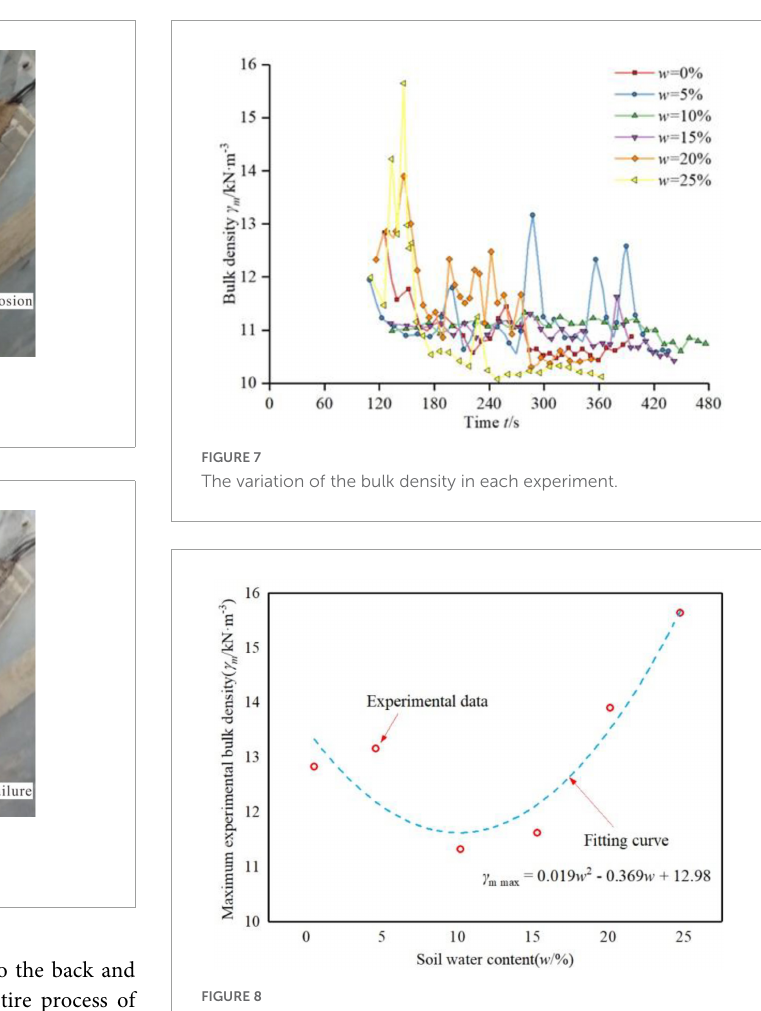
FIGURE8 The relationship between the water content and the maximum bulk